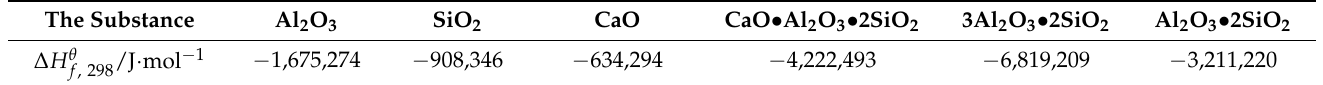
/J · mol − 1 ) of the substance at different f , 298